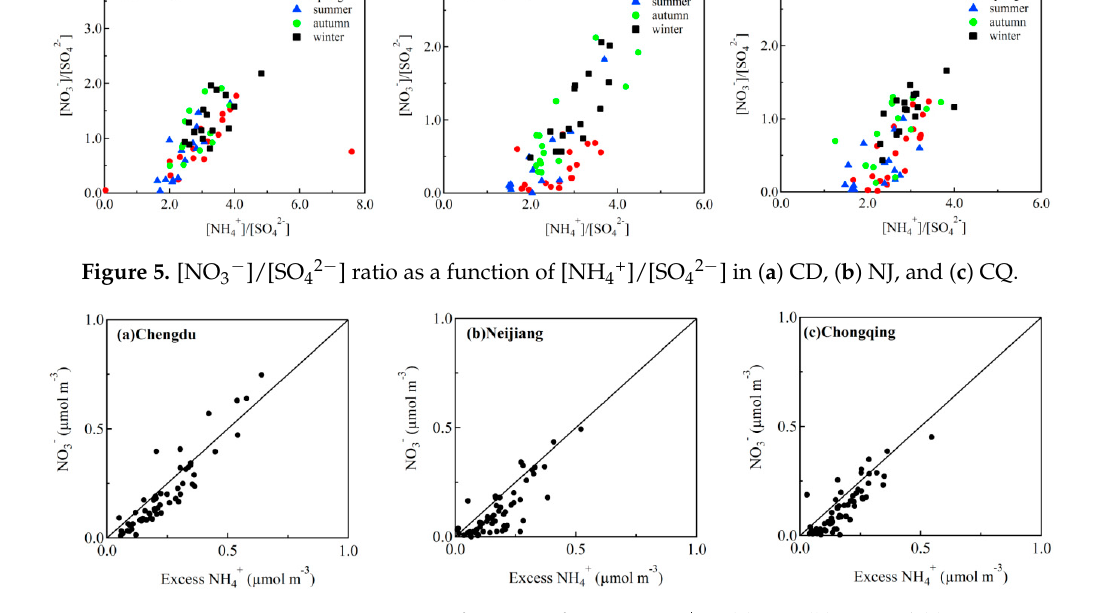
Figure 7. Relationship between [NO 3 − ]/[SO 42 − ] and [NH 4+ ]/[SO 42 − ] under different ( a ) acidity and ( b ) RH. 3.6. Source Analysis of WSIIs Principal component analysis (PCA) is applied in the study using SPSS version 16.0 software packages to explore the sources of WSIIs in CD, NJ, and CQ. In the analysis, all the WSIIs are considered as variables, and factors explaining more than 80% of the total variance are extracted. Varimax rotation is then used to redistribute the variance and provide a more interpretable pattern of the factors. Three factors in each city, with their component loadings, eigenvalues, and explained variance are displayed in Table 5. Factor 1 in CD covered 61.1% of the total variance, and had high loadings of Na + (0.74), NH 4 + (0.96), Cl − (0.77), SO 4 2 − (0.85), and NO 3 − (0.93). NH 4 + , SO 4 2 − , and NO 3 − are typical secondary ions, and Cl − is a tracer for coal combustion. Thus, factor 1 in CD was recognized as a mixture of secondary aerosols and coal combustion, and the good correlation between Na + and Cl − indicated their similar origins or coexistence in aerosols. In factor 2, 14.9% of the total variance was explained and loadings of K + and Ca 2+ were much higher than other variables, indicating the contribution from biomass burning and natural dust. Factor 3 was responsible for 8.5% of total variance, and was heavily loaded by Mg 2+ (0.89). Mg 2+ was from construction dust, and the factor was related with the wide reconstruction work in urban Chengdu. In NJ, the loadings of Na + (0.70), K + (0.68), Mg 2+ (0.81), and Ca 2+ (0.83) in factor 1 were high, and these were probably from natural dust and biomass burning. Factor 2 had high loadings of NO 3 − (0.88) and Cl − (0.88), indicating the influence from secondary nitrate and coal combustion. In factor 3, both loadings of SO 42 − (0.96) and NH 4+ (0.84) were high, and they were tracers for secondary sulfate. In CQ, factor 1, explaining 57.8% of total variance, had high loadings of NH 4+ (0.79), K + (0.79), and SO 42 − (0.89), and reflected a combination of biomass burning and secondary sulfate. Factor 2 was mainly affected by Na + (0.61), NH 4+ (0.55), Cl − (0.92), and NO 3 − (0.87), and was a mixed influence from